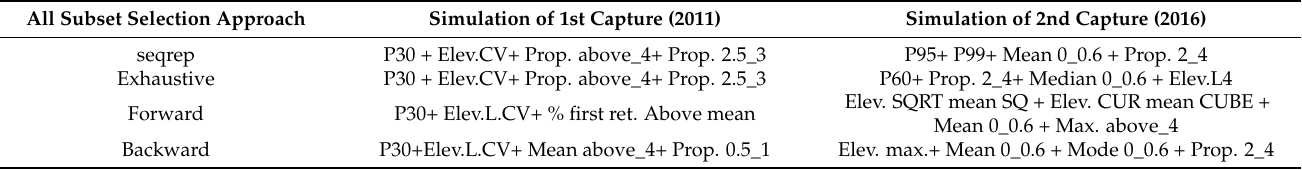
Table 7. All subsets selected metrics for 2011 and 2016. seqrep stands for sequential replacement. All Subset Selection